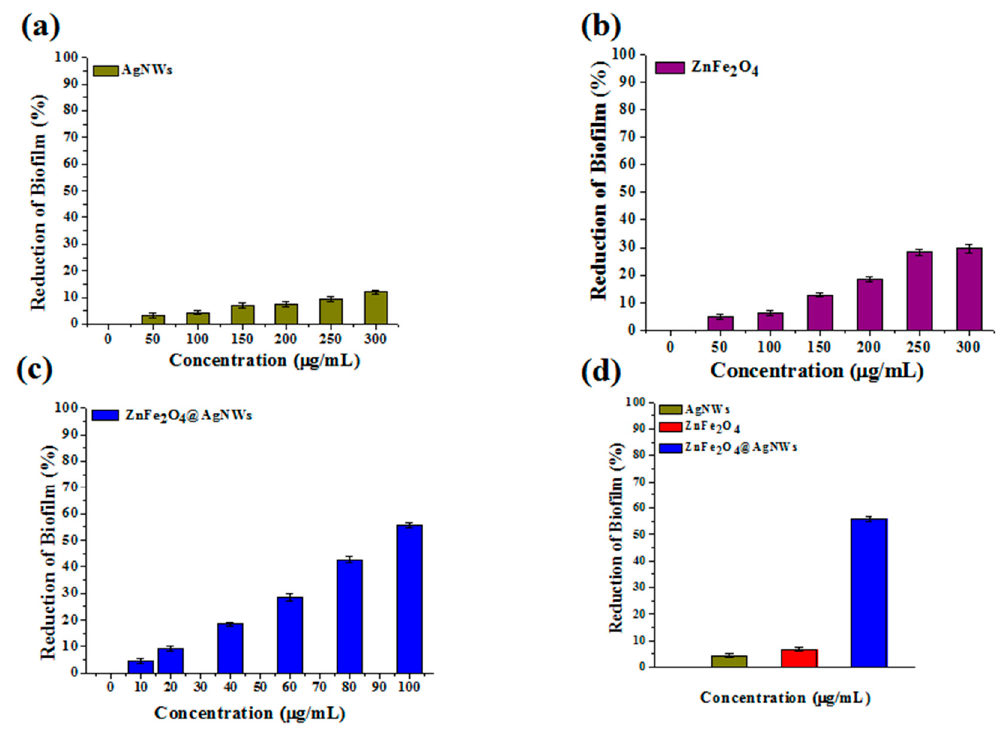
Figure 5. Reduction of biofilm versus nanostructure concentration bar charts obtained from XTT cell proliferation assays: ( a ) AgNWs, ( b ) ZnFe 2 O 4 NPs, ( c ) ZnFe 2 O 4 @AgNWs hybrid nanostructures, ( d )